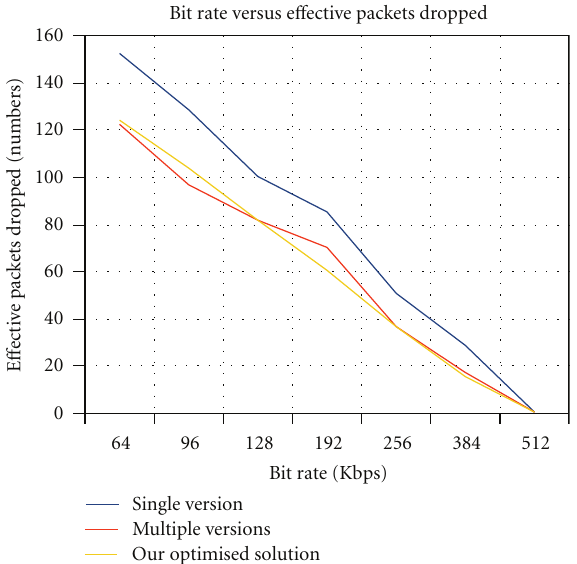
Figure 4: Bit rate (kbps) versus actual no. of packets